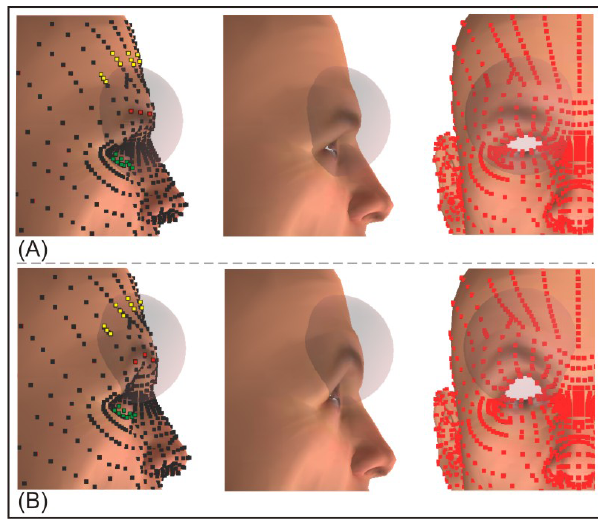
Figure 10. Moving influence zones. (A) Yellow points are initially outside the influence zone and green inside. (B) After the translation, the yellow points are inside and the greens are outside the sphere.